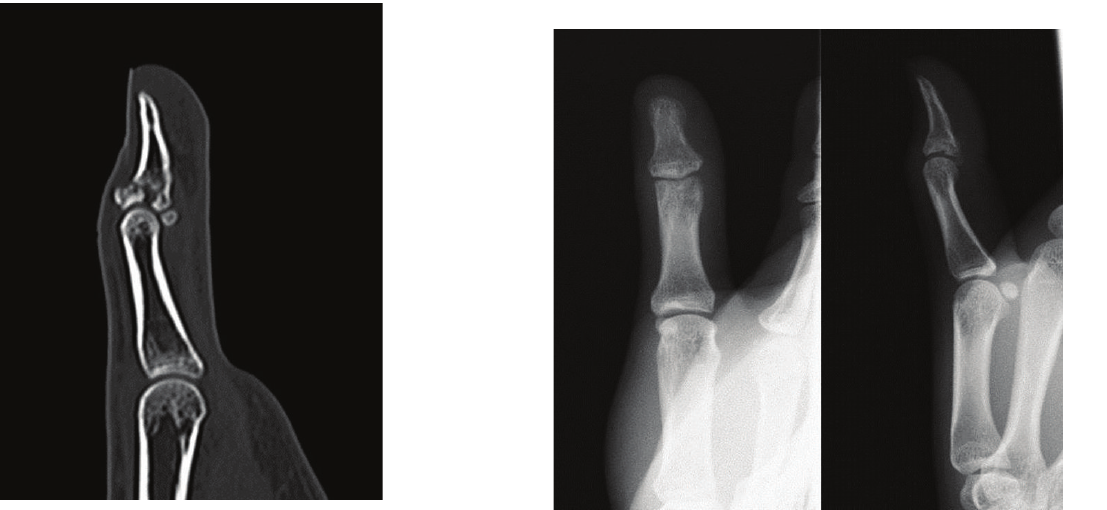
Figure 2: Computed tomography shows an avulsion fracture at the base of the distal phalanx involving more than half of the articular surface.